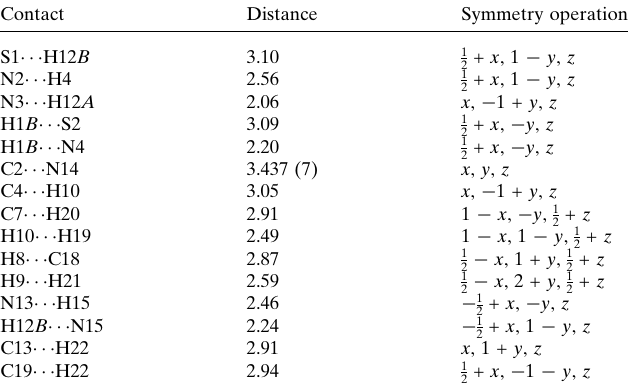
Table 2 Summary of short interatomic contacts (A˚ ) in the title compound.